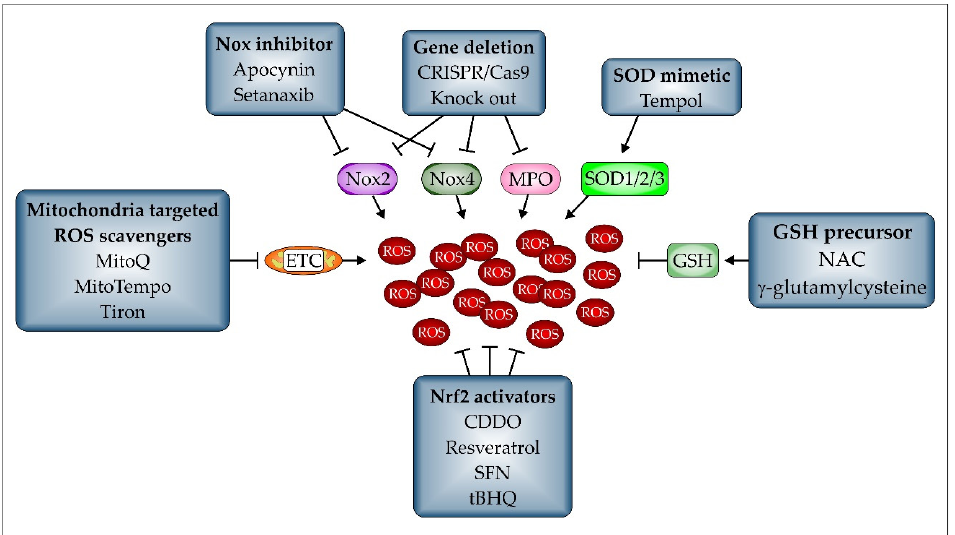
Figure 6. Therapeutic concepts to reduce and prevent ROS formation. Several approaches have been tested in the murine model to reduce and prevent ROS formation during lung inflammation. Considering the major factors involved in ROS formation, such as Nox2, Nox4, MPO, and the ETC, specific inhibitors or compounds targeted to mitochondria were shown to be effective in improving ALI. SOD mimetics, which only reduce the amount of generated O 2 − , have also been found to have an impact. Additionally, GSH precursors, maintaining a high intra- and extracellular GSH-pool, leading to a more reductive environment, are potent in depleting ROS. Finally, activators leading to the stabilization and thus activation of the transcription factor Nrf2 have been shown to significantly contribute to the expression of factors important in detoxifying ROS. However, one further possibility in the murine system, gene deletion, is still difficult to achieve in the human patient. Vitamin C has also been identified as an antioxidant with a protective function in murine acute lung injury [193]. The mice received either ascorbic acid (AscA) or dehy- droascorbic acid (DHA) 30 min following abdominal sepsis induction by intraperitoneal cecal slurry injection [194]. Both treatments reduced lung injury by differing mechanisms, involving reduced epithelial barrier breakdown, maintaining alveolar fluid clearance, pre- venting tight junction loss, and inhibiting rearrangement of the cytoskeleton [194].